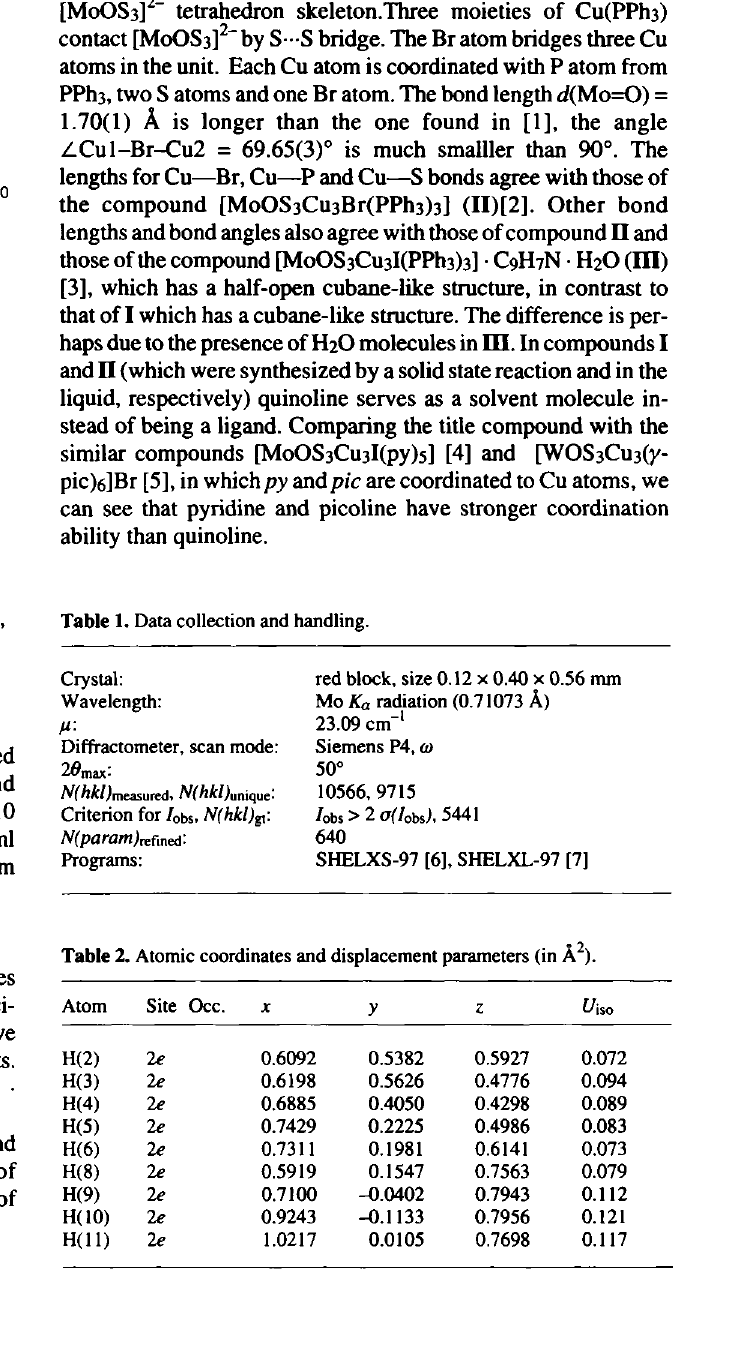
Table 2. Atomic coordinates and displacement parameters (in Â 2